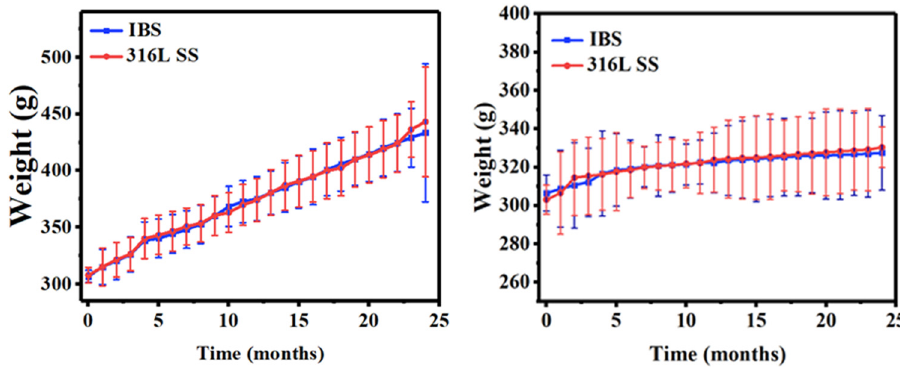
Figure 1: The curves of body weight.